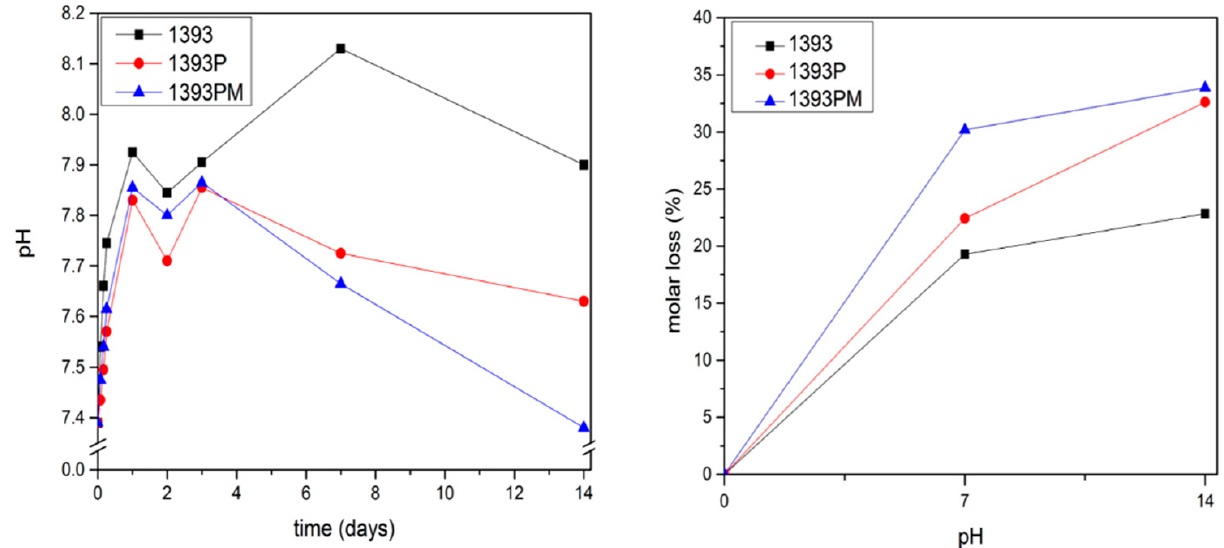
Figure 8. Molar loss of 1393 scaffolds, 1393 coated with PGSuc (1393P), and 1393 coated with PGSuc and MSNs (1393PM).